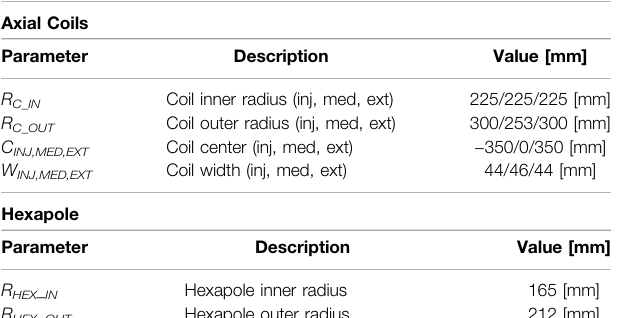
FIGURE 5 | Magnetic fi eld module, | B |, along a circumference of radius R CH _ IN = 140 mm (plasma chamber inner radius) and axial position z = 0